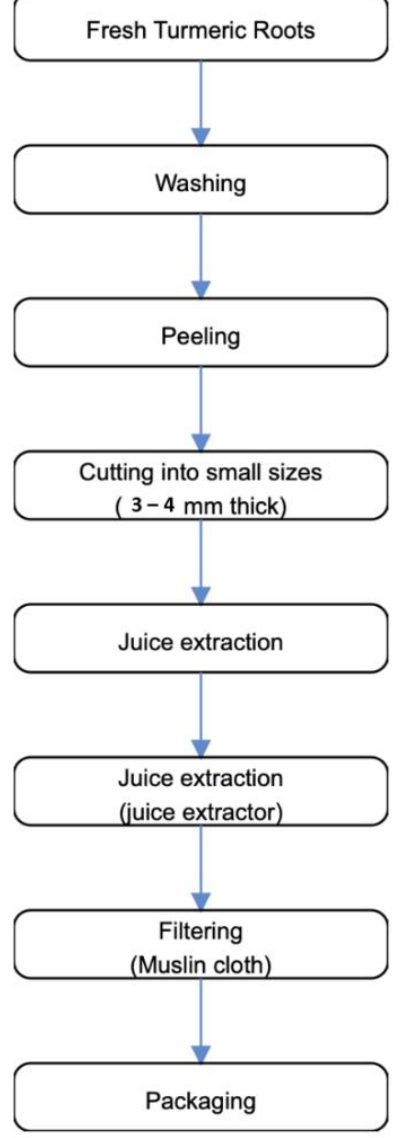
Figure 3. The preparation of turmeric juice (Source: Top 10 Home Remedies Team [29]). The preparation of ginger juice is similar to that of turmeric juice. Fresh ginger roots were washed under clean running tap water, peeled, and then cut into smaller pieces, thereafter, they were subjected to blending, and at the same time, supplemented with little amounts of clean/filtered water to ease friction during blending. The juice pulp was then filtered using a sterile muslin cloth to get the juice, which was then refrigerated at ~4 ◦ C, until